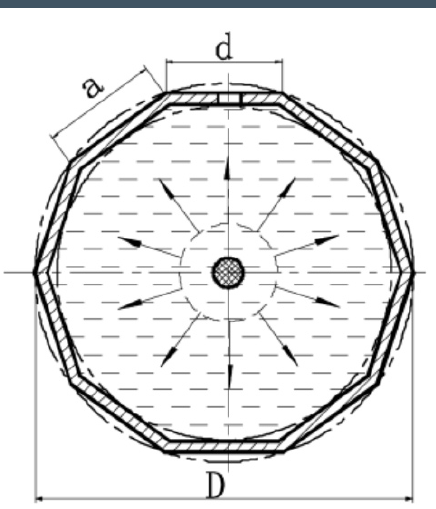
Figure 5. Position of explosive charge inside water filled model.